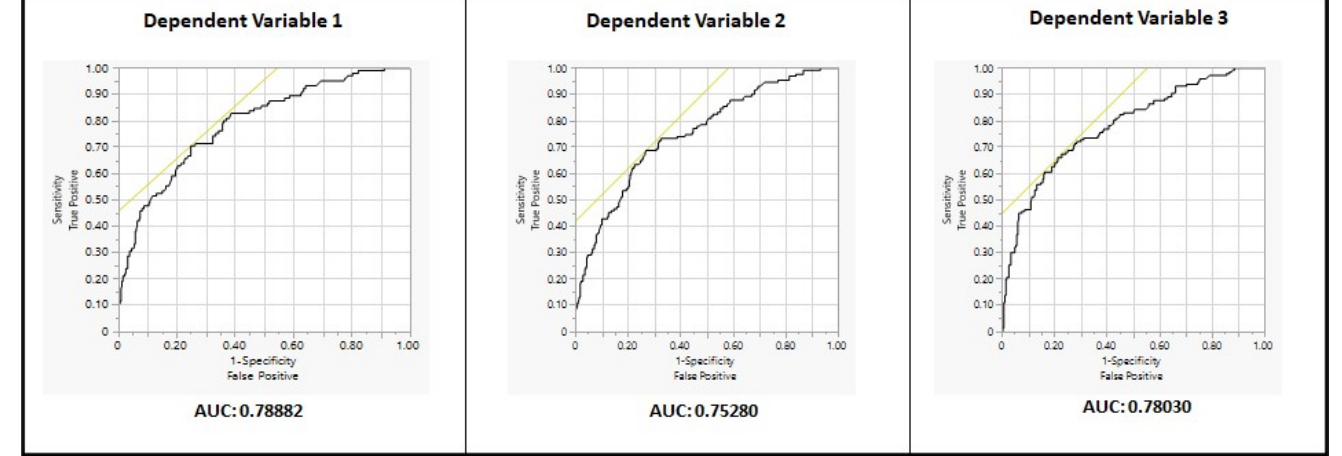
Figure 2. ROC curves for all three logistic regression models (DV1, DV2, and